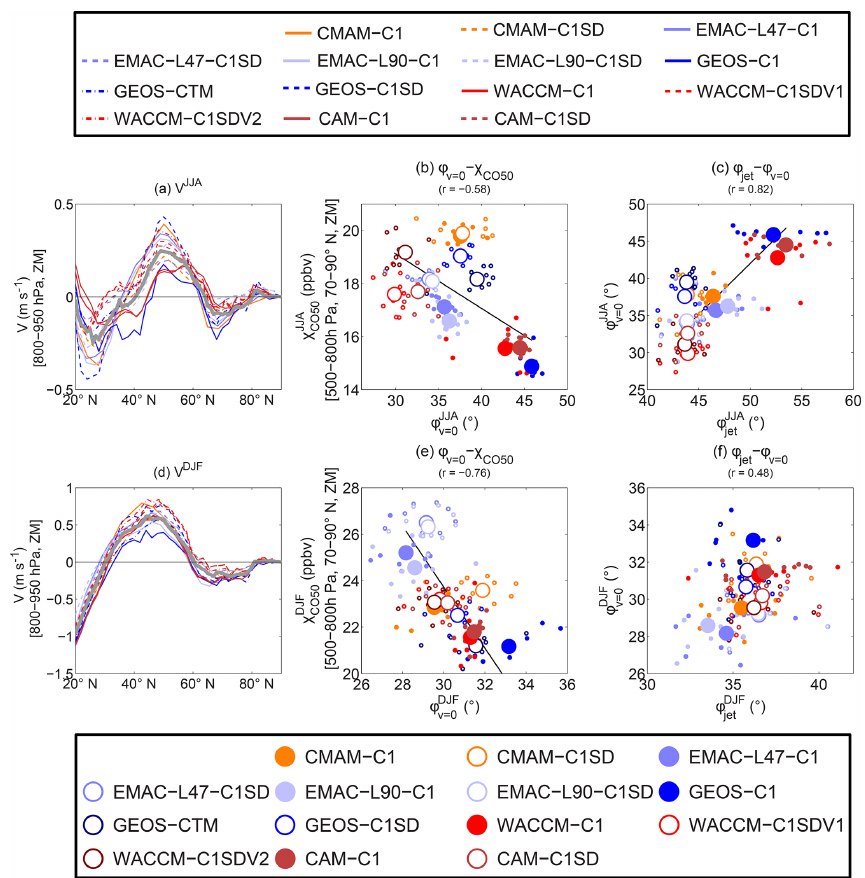
Figure 10. Similar to Fig. 9 in (a) , (b) , (d) , and (e) , but for low-level (800–950hPa) zonal-mean meridional wind v and φ v = 0 marking the latitude for low-level v switching from southward flow in the south to northward flow in the north. The correlations between φ v = 0 and jet location φ jet are further shown in (c) and (f)